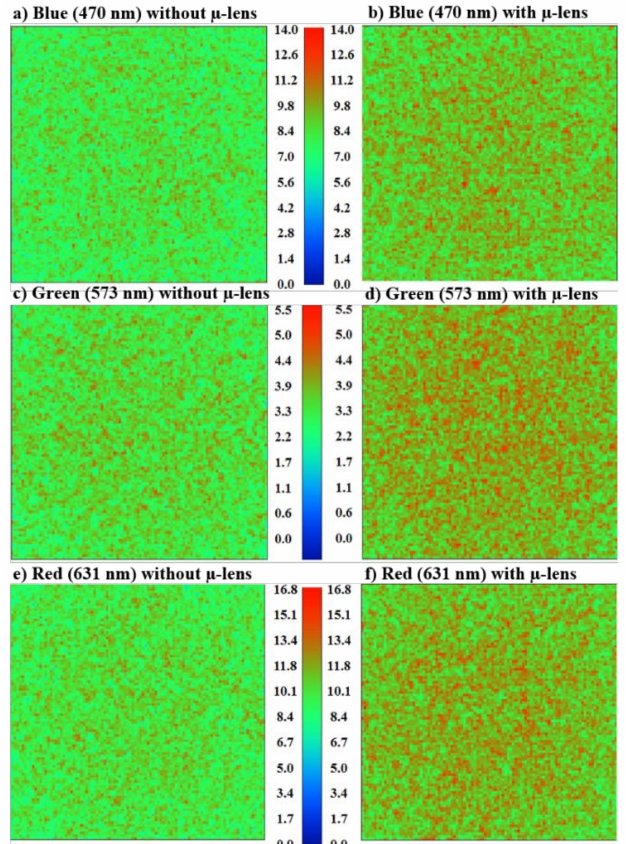
Figure 3. ZEMAX ® irradiance maps simulation results for: blue LED ( a ) without µ -lens and ( b ) with µ -lens; green LED ( c ) without µ -lens and ( d ) with µ -lens; and red LED ( e ) without µ -lens and ( f ) with µ